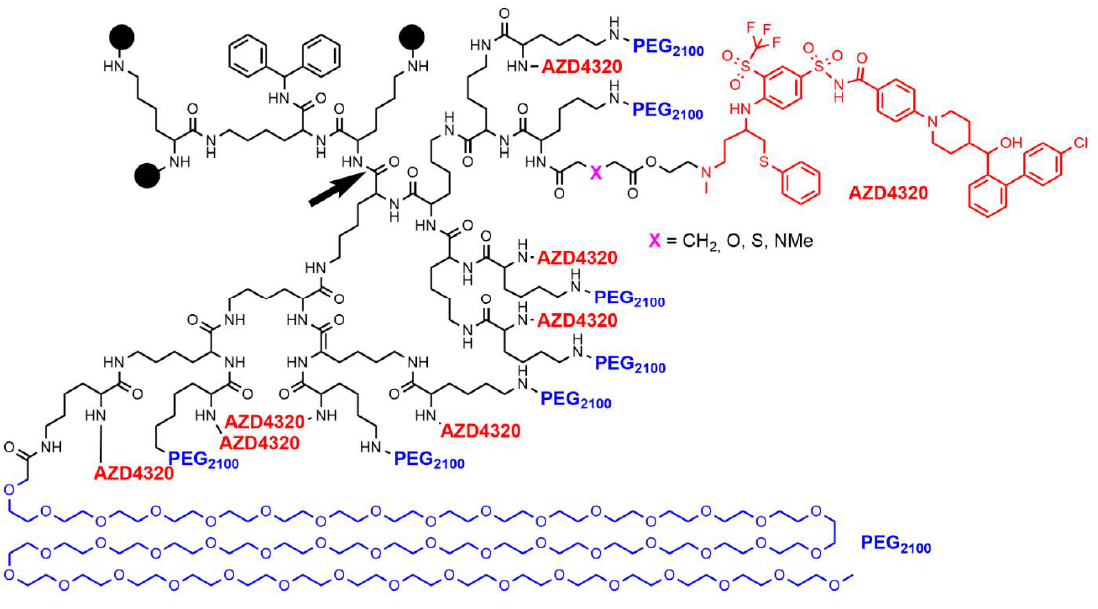
Figure 3. Structure of dendrimer AZD0466 (X = N-Me). The black bowls represent the structure that is shown after the black arrow.